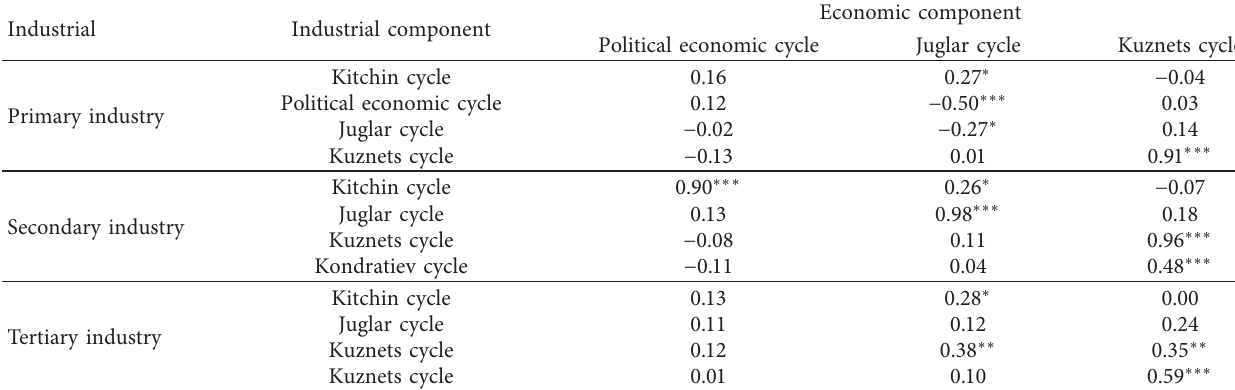
Table 5: Correlation between industrial and economic cycle components of Liaoning Province.